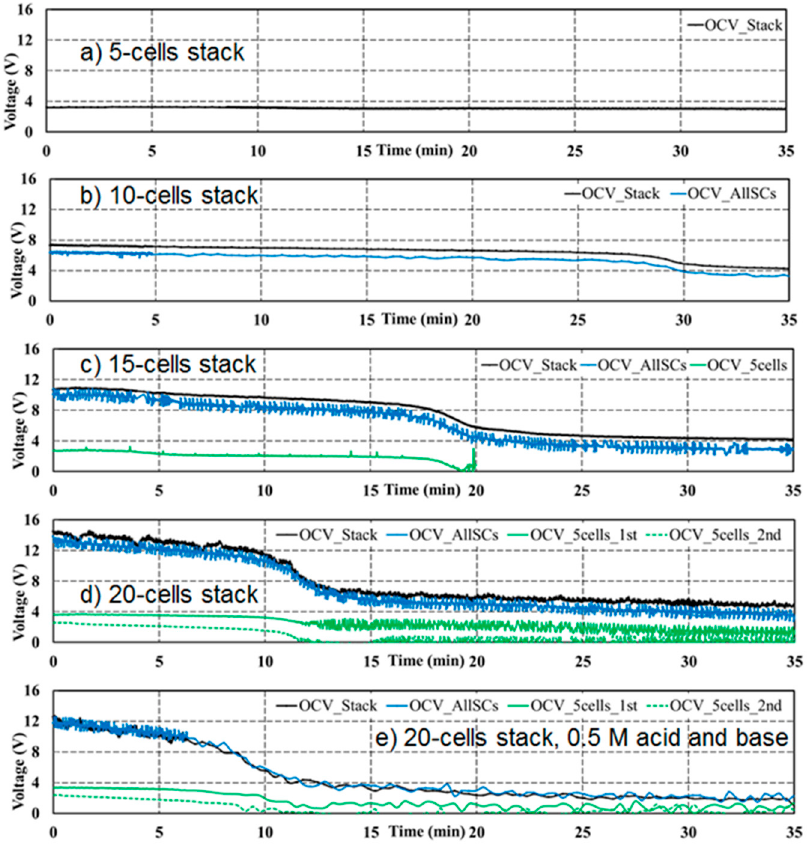
Figure 4. Self-discharge test at 25 °C for different stack sizes and different acid and base concentrations. ( a ) 5-cell stack, 1M acid and base, ( b ) 10-cell stack, 1M acid and base, ( c ) 15-cell stack, 1M acid and base, ( d ) 20-cell stack, 1M acid and base, ( e ) 20-cell stack with 0.5 M acid/base concentration. OCV_Stack (black) has been measured between the electrodes, OCV_AllSCs (blue) between the first and the last repeating cell unit of the stack, OCV_5cells_1st (green solid) and OCV_5cells_2nd (green, dotted) have been measured across the first and second 5-cell unit.